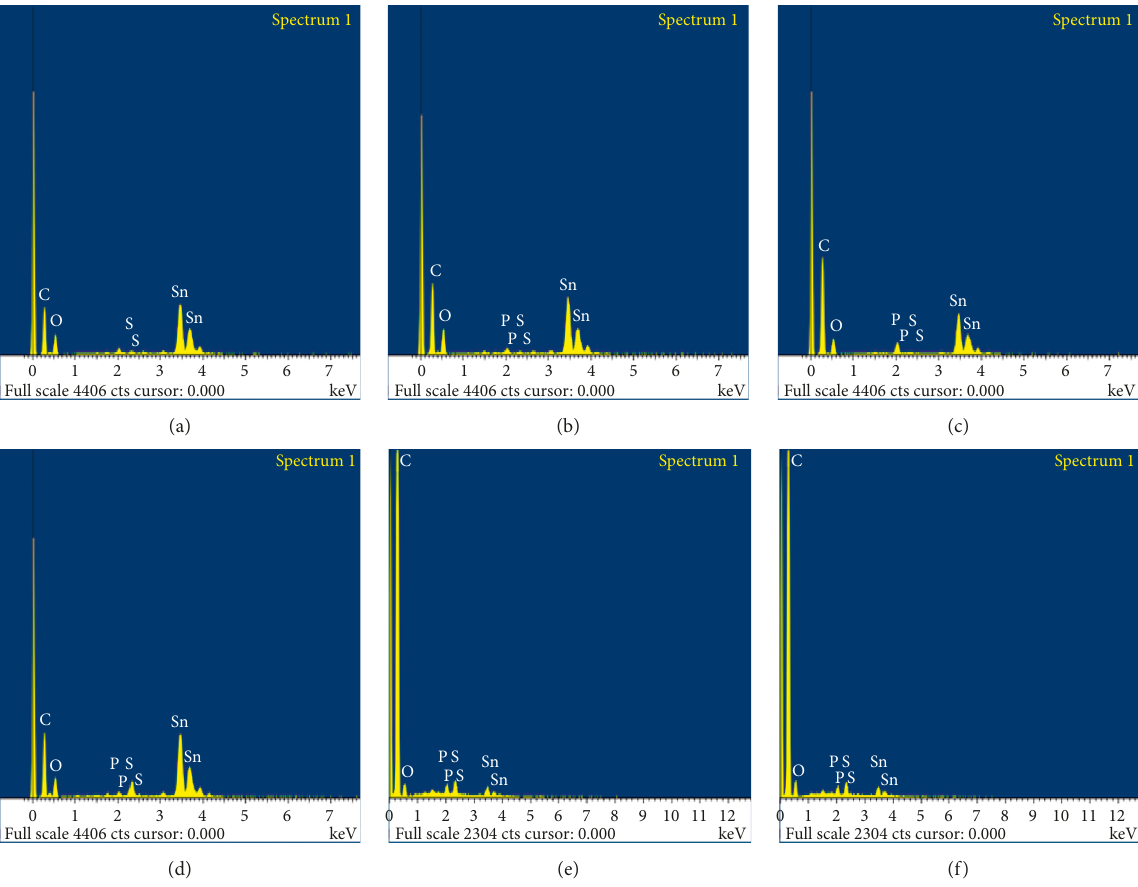
Figure 4: EDX spectra of OASnS1 (a), OASnS2 (b), OASnS3 (c), ODASnS1 (d), ODASnS2 (e), and ODASnS3